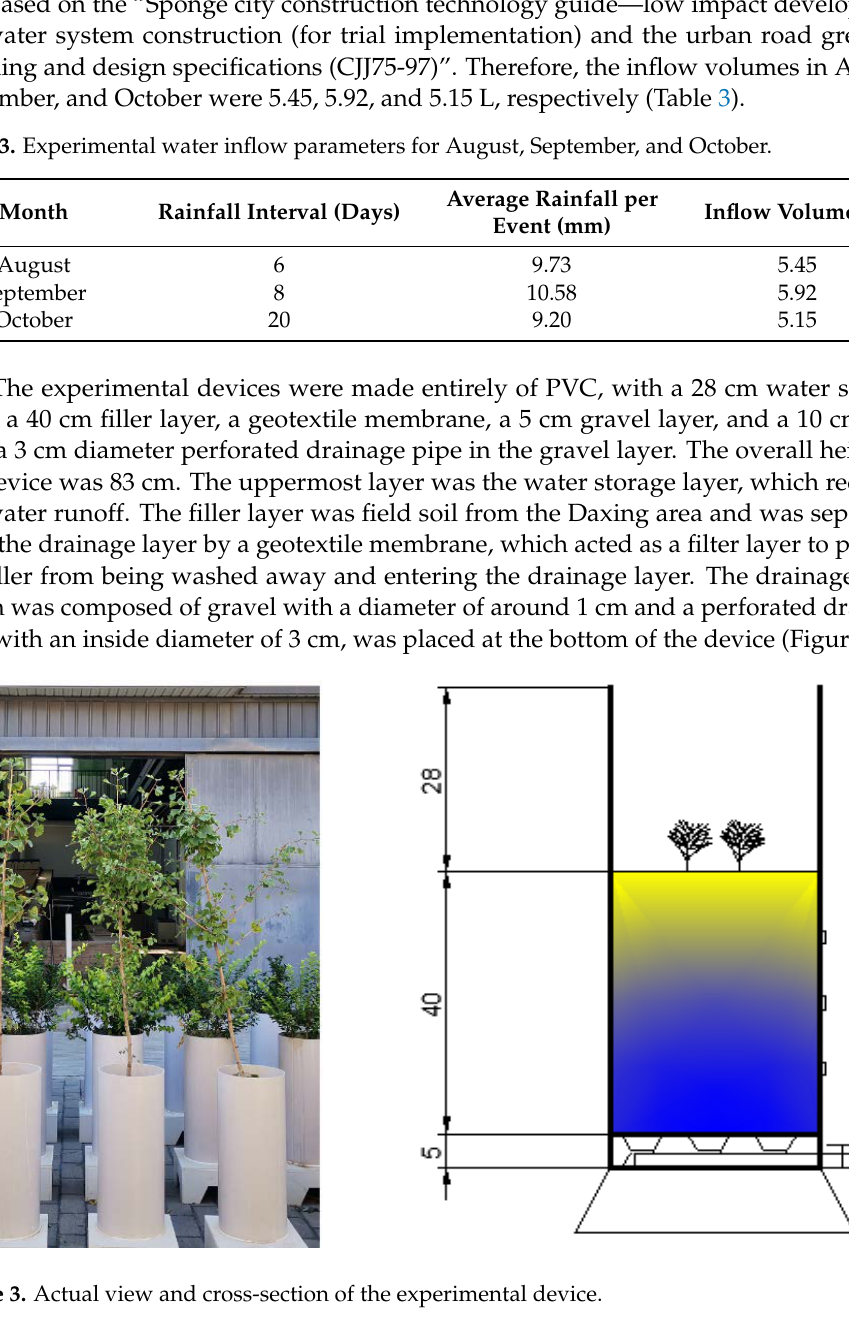
Figure 3. Actual view and cross-section of the experimental device.